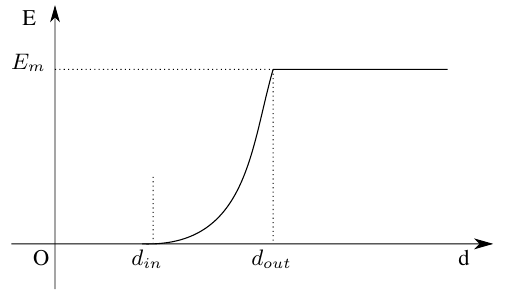
Figure 1: Data attachment energy regarding the 2D point to tra- jectory distance d